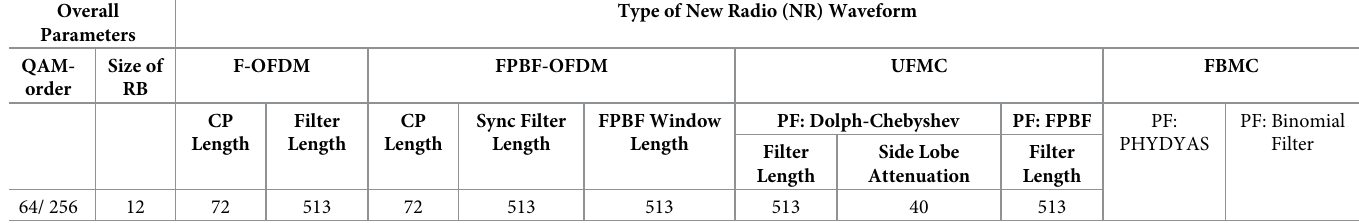
Table 1. Simulation parameters for different waveforms.